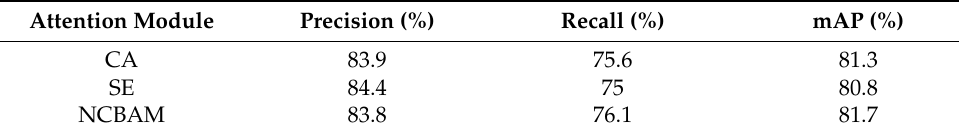
Table 4. Comparison results of different attention modules.